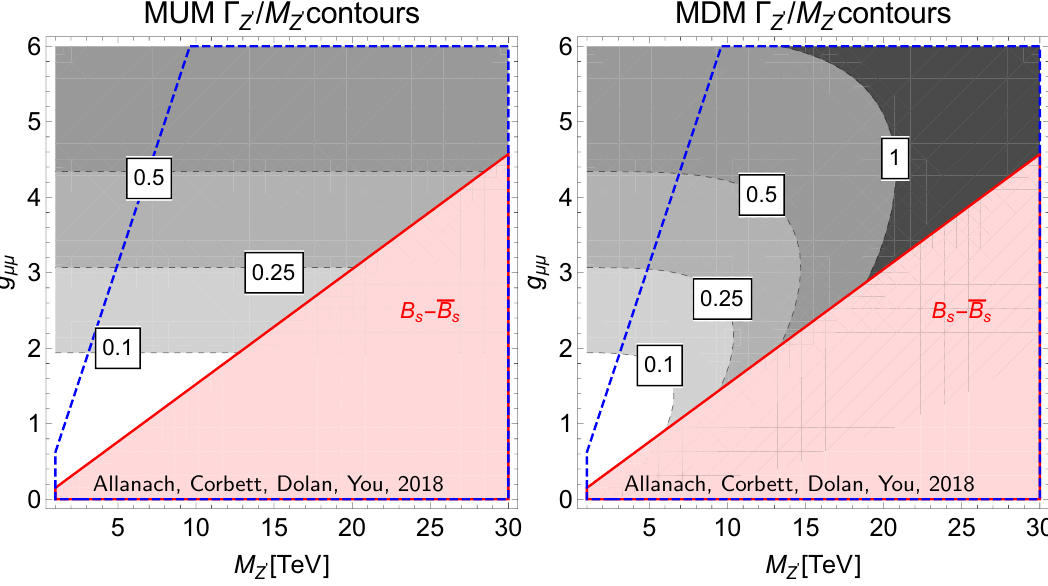
Figure 3 . Width of the Z 0 as a fraction of its mass as a function of M Z 0 and g (cid:22)(cid:22) in the MUM (left hand panel) and MDM (right hand panel) models, derived from Each point in the plane (cid:12)ts the neutral current B -anomalies, since eq. (2.2) with x = 1 : 00 has been enforced meaning that g bs / M 2 =g (cid:22)(cid:22) . The black region at the top right hand panel has width greater or equal to the Z 0 mass, meaning that the model has entered the non-perturbative r(cid:19)egime, and our results (based on perturbation theory) may be inaccurate there. In order to show more of the parameter space, we have displayed the pre-2016 B s mixing constraint in pink and the one based on eq. (2.3), where the region below the blue dashed line is ruled out.